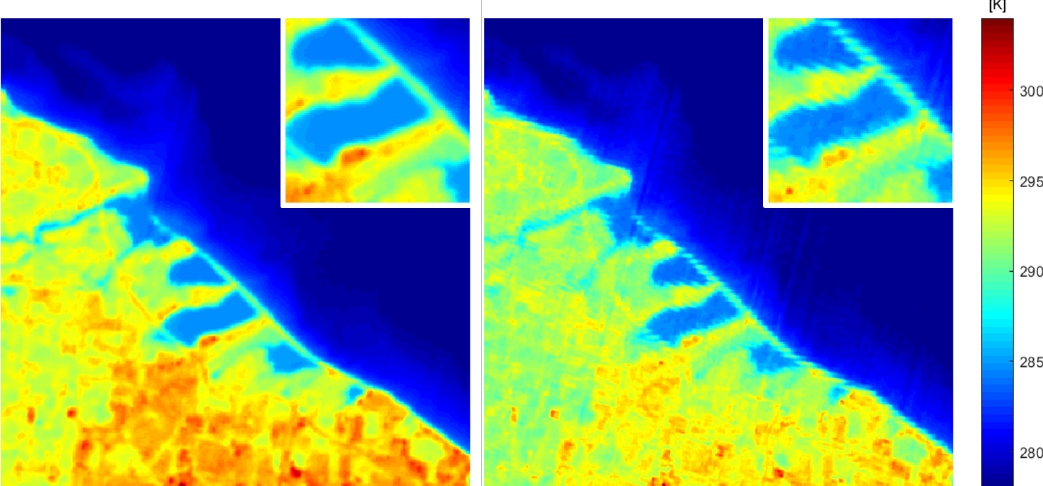
Figure 3. Comparison of the surface temperature product derived from the single channel method ( left ) against the split window method ( right ) for an area around Lake Ontario, NY (Landsat scene ID: LC08_L1TP_016030_20190413_20190422_01_T1). Note the spatial artifacts along edges in the split window product. Zoom windows are shown in the upper right of each image. The image area is roughly 8 by 8 km, and north is up.